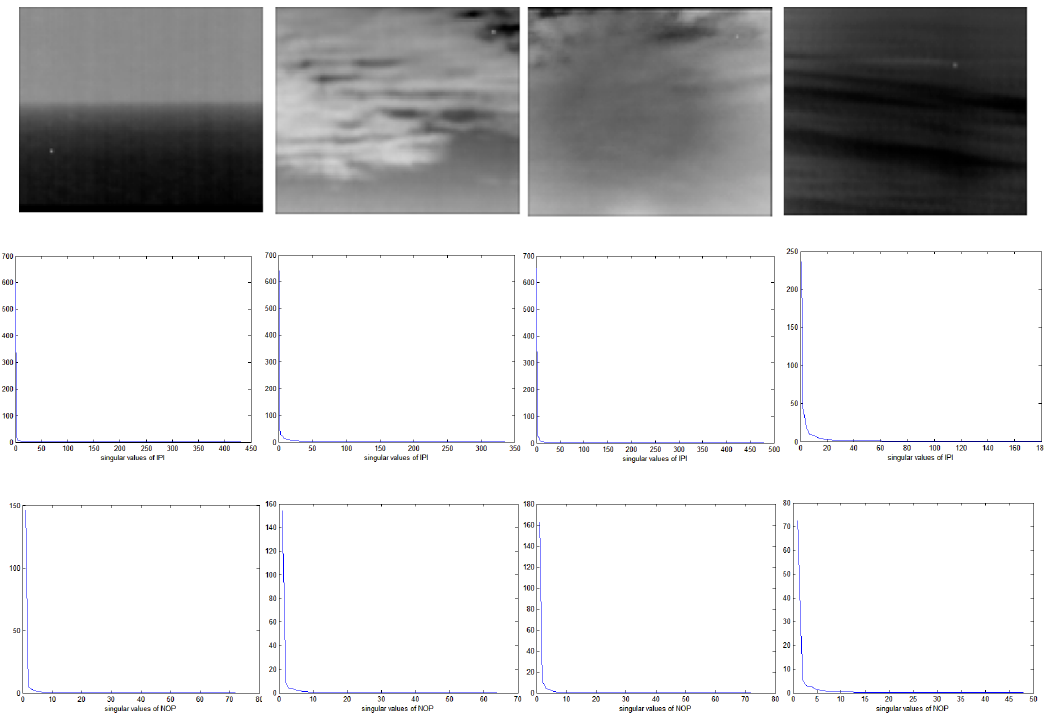
Figure 2. Low-rank property of four representative scenes. The first rows are four typical scenes, the second rows are singular values of IPI, and the third rows are singular values of NOP.